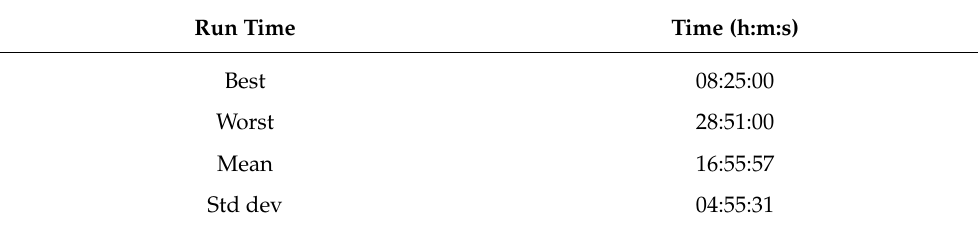
Table 7. Experiments measures: running time for Scenario Scenario